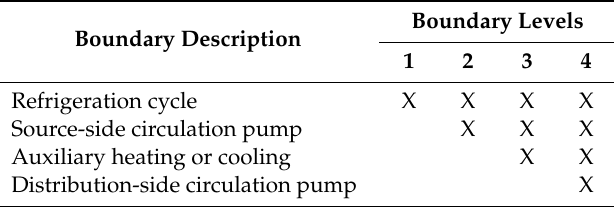
Table 1. SEPEMO system boundary scheme.